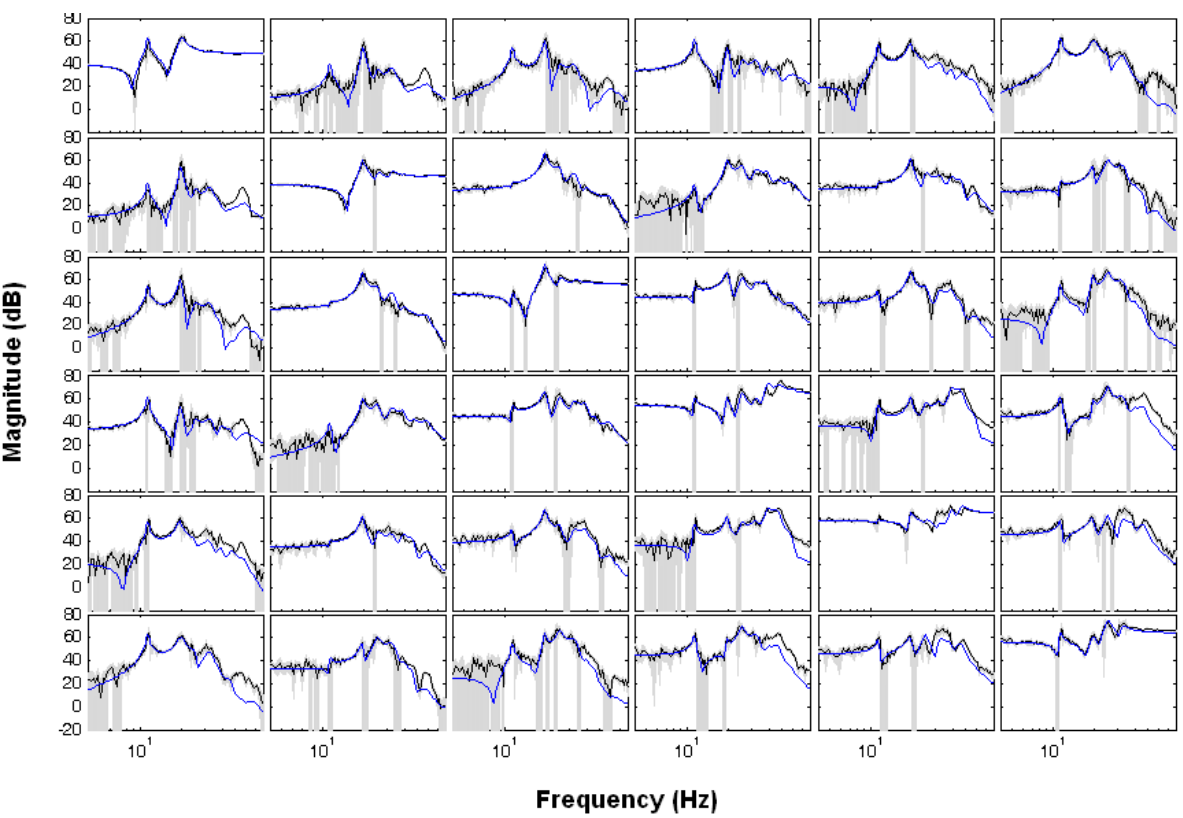
Figure 3: Multivariable Frequency Response Functions (FRF) for a modern industrial robot, describing the dy- namics between motor torques and motor accelerations. A dynamic model with 12 spring-damper pairs has been globally matched to the experimentally obtained FRF:s measured at several robot configura- tions to obtain a global dynamic model. The noisy (black) line is the measured FRF and the other (blue) line is the FRF obtained from the identified model. The shaded (gray) regions represent one standard deviation for the